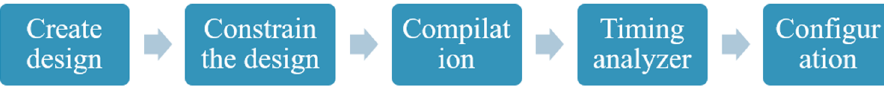
Figure 5. Summary of design and implementation process.